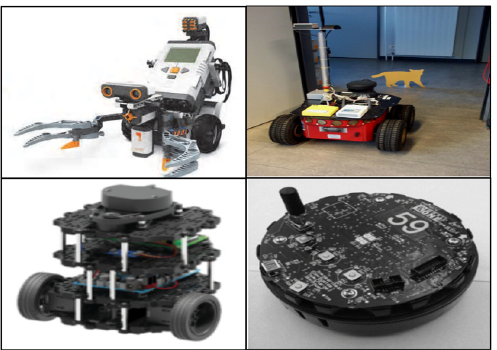
Figure 1. Educational robotic platform: LEGO kit, Pioneer, Turtlebot, and R-one